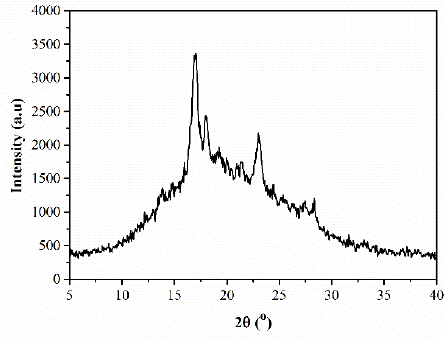
Figure 3. XRD pattern of the PEN ‐ Ph system.